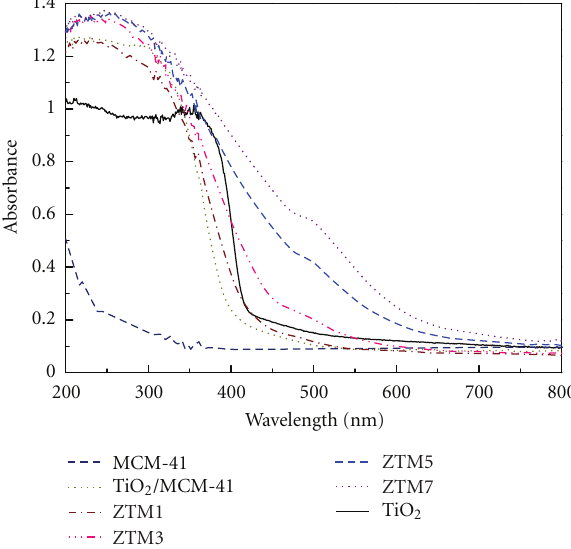
Figure 13: UV-vis spectra of TiO 2 , MCM-41, TiO 2 /MCM-41, and ZTM series